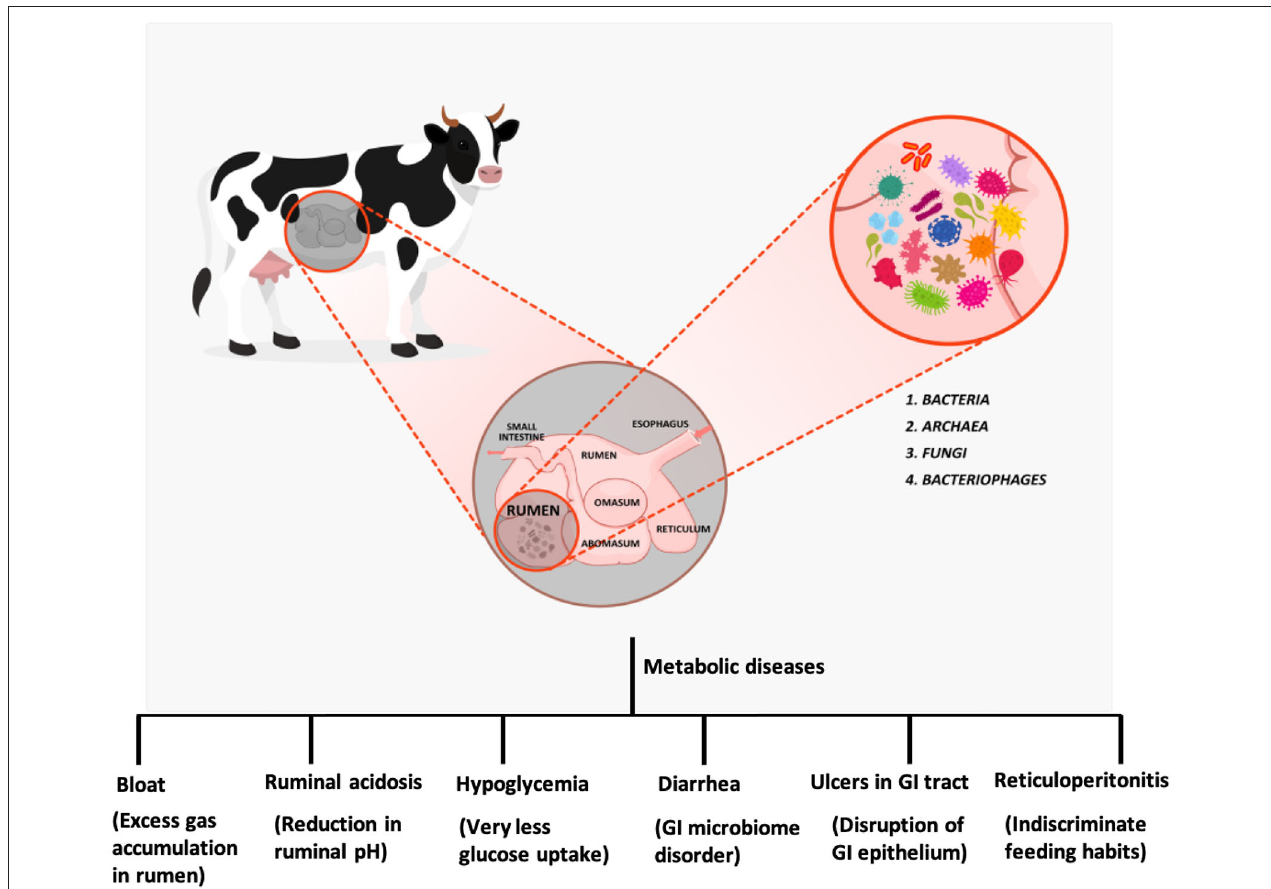
FIGURE 1 | Ruminant digestive system, microflora and metabolic diseases in